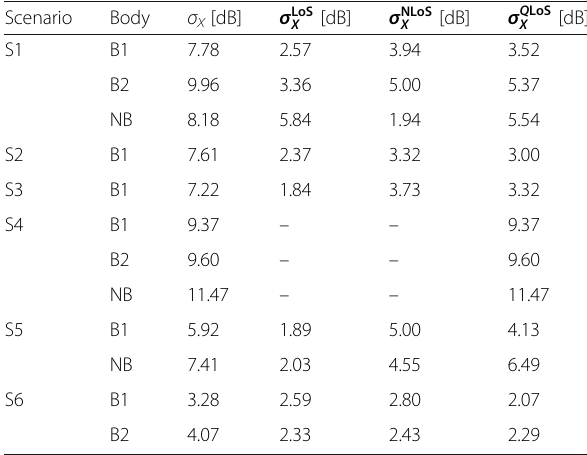
Table 4 Standard deviation of XPD for different